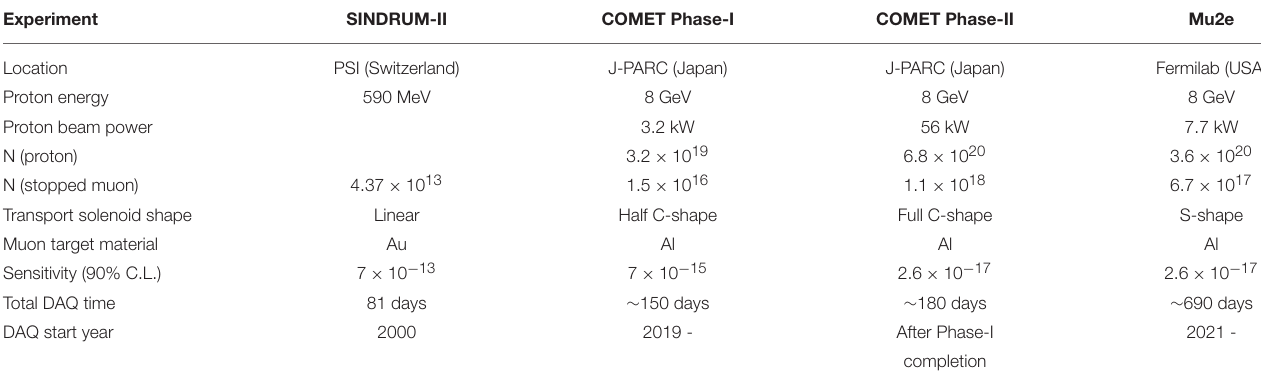
TABLE 1 | Comparison of µ − e conversion experiments.